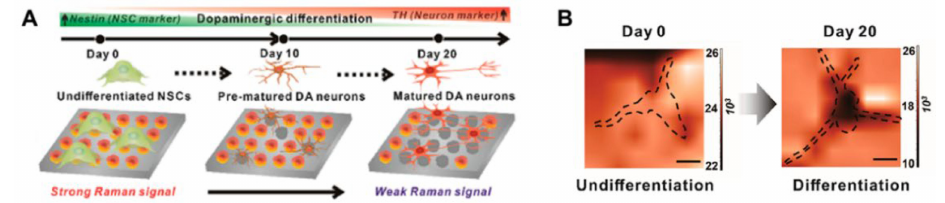
Figure 6. ( A ) Schematic illustration of characterization of neural differentiation using GO-hybrid nano-SERS array. ( B ) SERS mapping imaging before and after neural differentiation. Adapted with permission from Ref. [194]. Copyright 2020 American Chemical